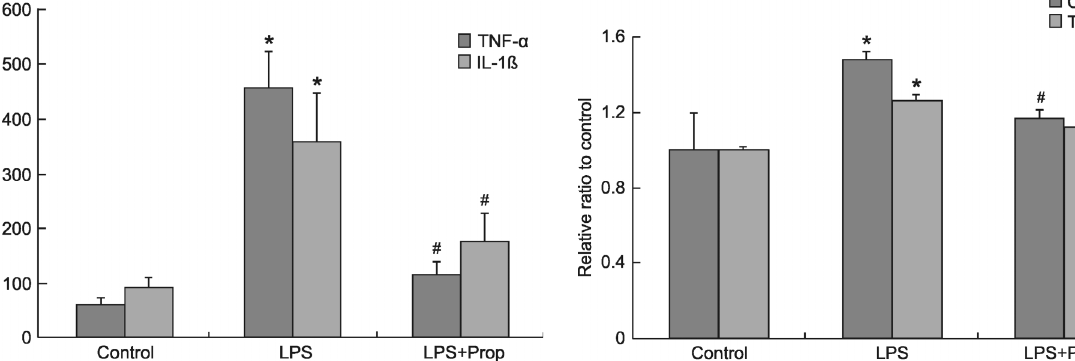
Figure 3. CD14 and TLR4 mRNA expression in lung tissue samples. Using real-time PCR, samples taken after each animal had received 5 h of intravenous LPS infusion were examined for CD14 and TLR4 mRNA expression. For each experimental condition, CD14 and TLR4 mRNA expression was normalized with GAPDH mRNA. Data are reported as means ± SD for n = 8 animals per experimental group. CD14 = cluster of differentiation 14; TLR4 = Toll-like receptor 4; LPS = lipopolysaccharide; Prop = propofol. *P , 0.05 compared to control; # P , 0.05 compared to LPS group (ANOVA followed by the post hoc Tukey